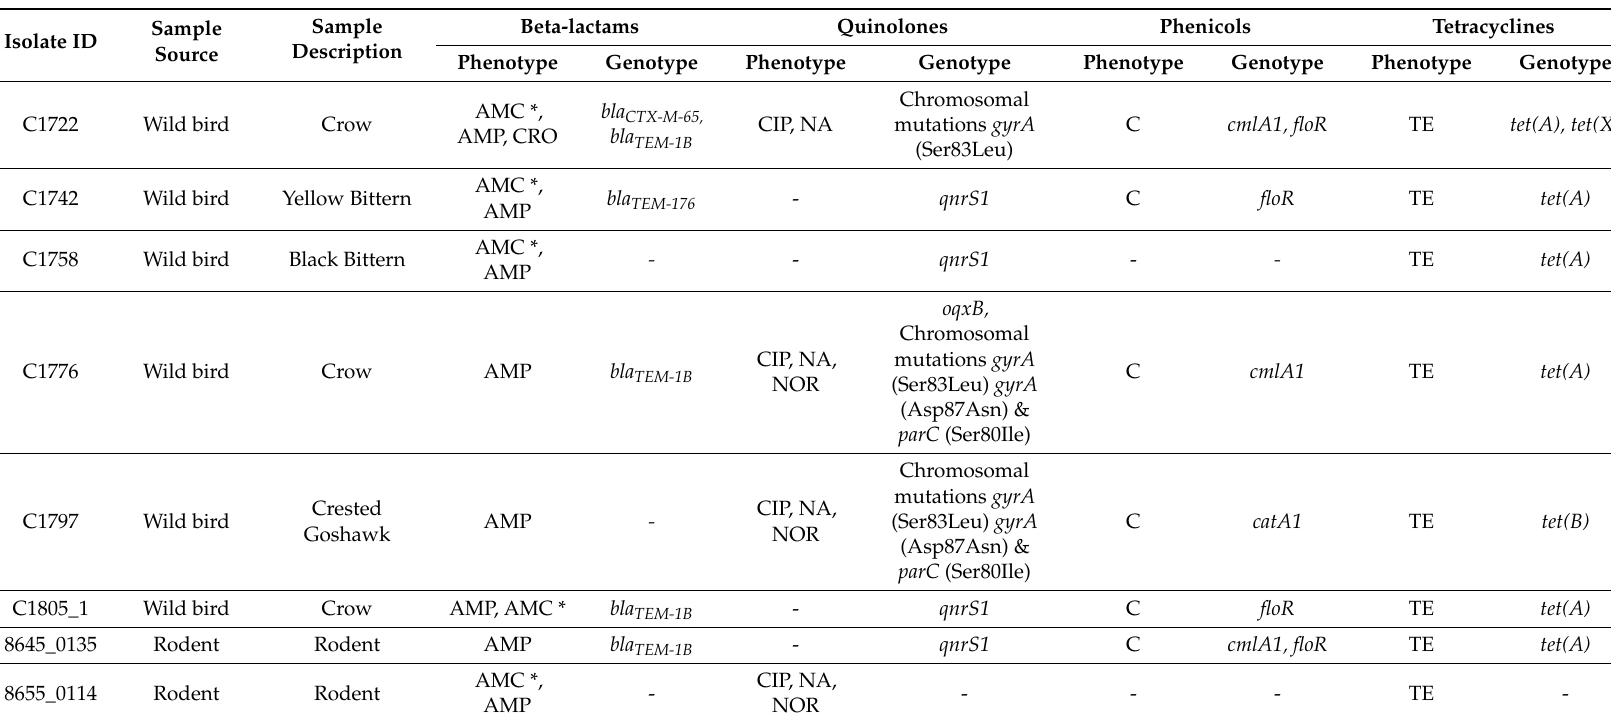
Table 6. Comparison of antimicrobial resistance phenotype and genotype of the eight multi-drug resistant E. coli isolates for the selected antimicrobial agents (AMC: Amoxicillin / Clavulanic acid; AMP: Ampicillin; C: Chloramphenicol; CIP: Ciprofloxacin; CRO: Ceftriaxone; NA: Nalidixic acid; NOR: Norfloxacin; TE: